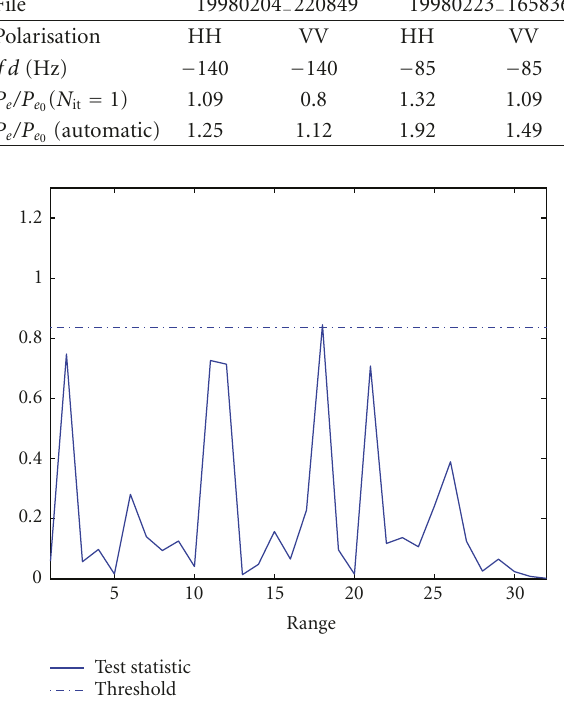
Figure 10: Test statistic in homogeneous real sea clutter from file 19980223 − 165836, with N = 8, K = 32, N it = 1, and P e